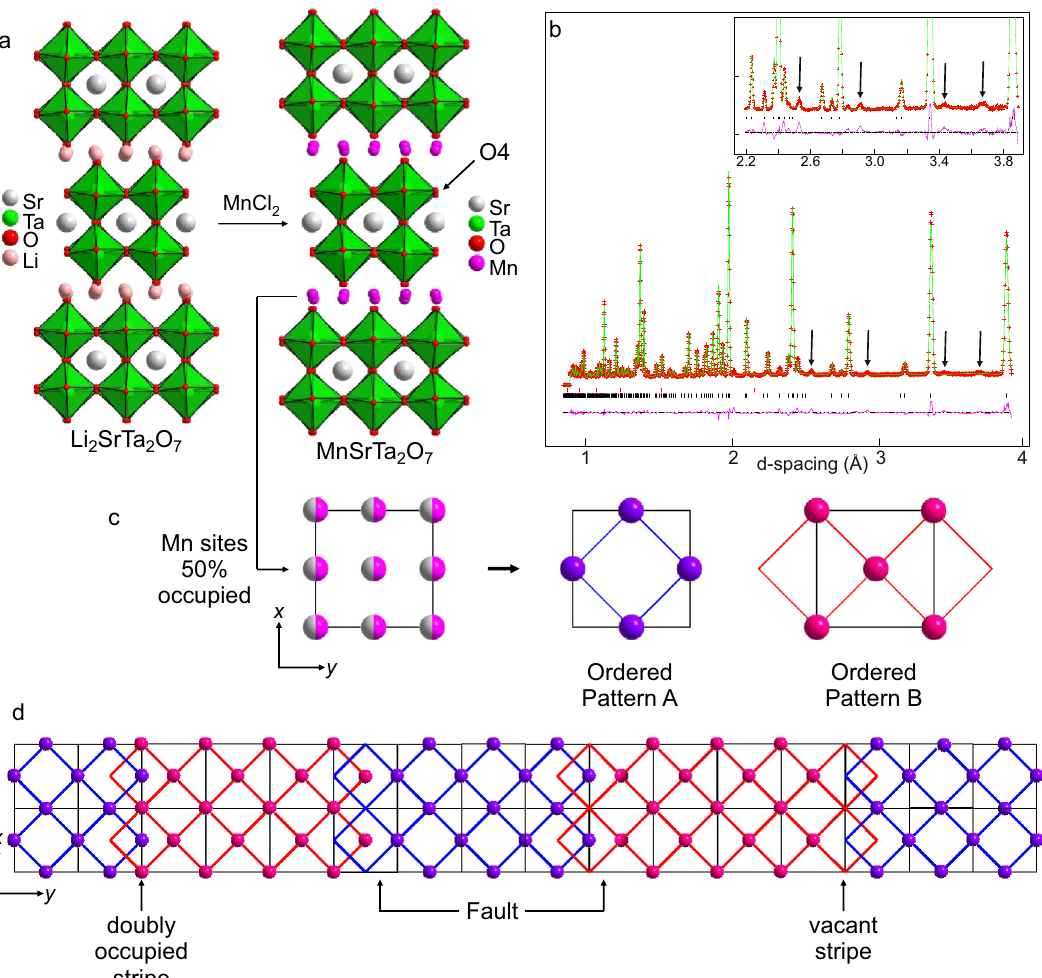
Fig. 2 Polar, incommensurate structure of MnSrTa 2 O 7. a Reaction with MnCl 2 converts Li 2 SrTa 2 O 7 into MnSrTa 2 O 7 via topochemical Mn-for-Li cation exchange. b Observed (red crosses), calculated (green line), and difference (purple line) plots from re fi nement of an A 2 1 am symmetry structural model against NPD data collected from MnSrTa 2 O 7 at 300 K. A series of peaks (marked by arrows) are not fi t by this model and can only be indexed with an incommensurate unit cell. c Half occupancy of the pseudo tetrahedral coordination sites by Mn 2 + allows two different local chequerboard orderings. d An approximate representation of the incommensurate intergrowth of the two Mn-ordering patterns, which propagates along the crystallographic y axis. Locally ordered regions are joined by doubly occupied/vacant stripes or “ faults ” which run parallel to the x